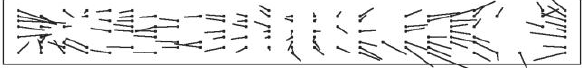
Figure 8. Discrepancies at GCPs of overlaid 10 afterward images, interpolates to raster arrangement